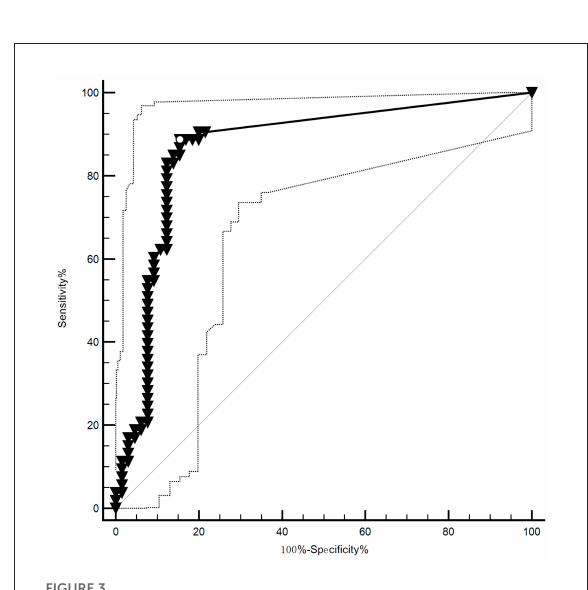
FIGURE3 The ROC of the TP antibody index in neurosyphilis. The AUC of the CSF_TPPA index antibody index was AUC: 0.867 (0.792, 0.922), with its optimal cutoff points for the identification of NS being ≥ 0.81, providing a sensitivity of 88.91% and specificity of